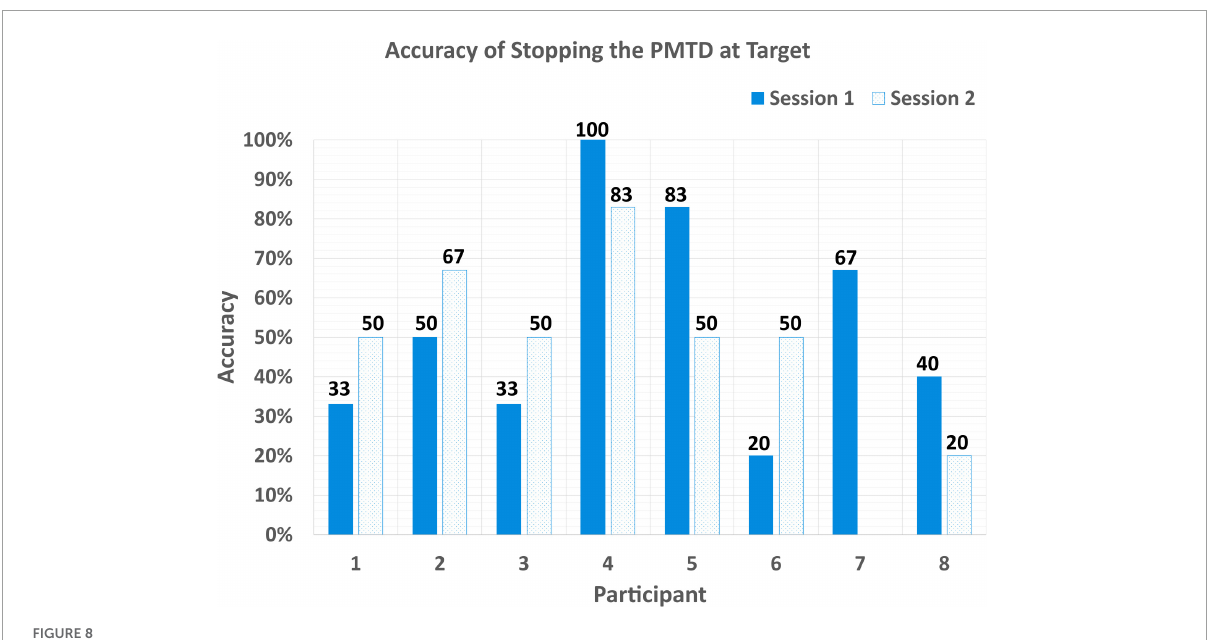
FIGURE8 Accuracy of successfully stopping the PMTD within 1 m of a target.